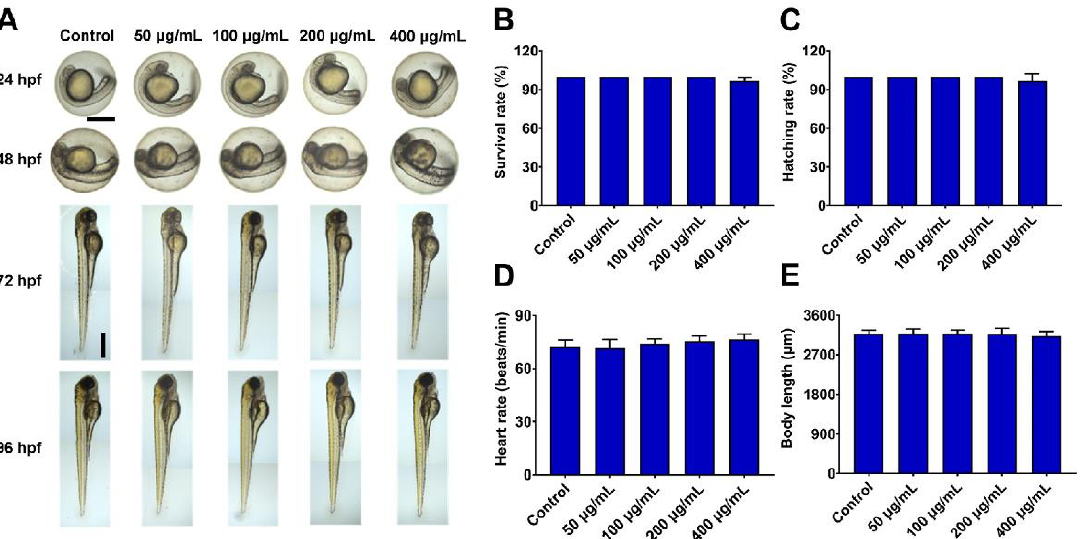
Figure 2. In vivo toxicity analysis. At 3 hpf, zebrafish embryos were treated with 50, 100, 200, and 400 μg/mL GB -PPNPs. At 96 hpf, embryo morphology was visualized via microscopy, and survival rates, hatching rates, heart rates, and zebrafish body length were calculated. ( A ) The phenotypic changes of GB-PPNP- treated zebrafish embryos at the indicated times. Scale bar: 500 μm. Survival rate ( B ), hatching rate ( C ), heart rate ( D ), and body length ( E ) following incubation with different GB-PPNP treatments ( n = 3).